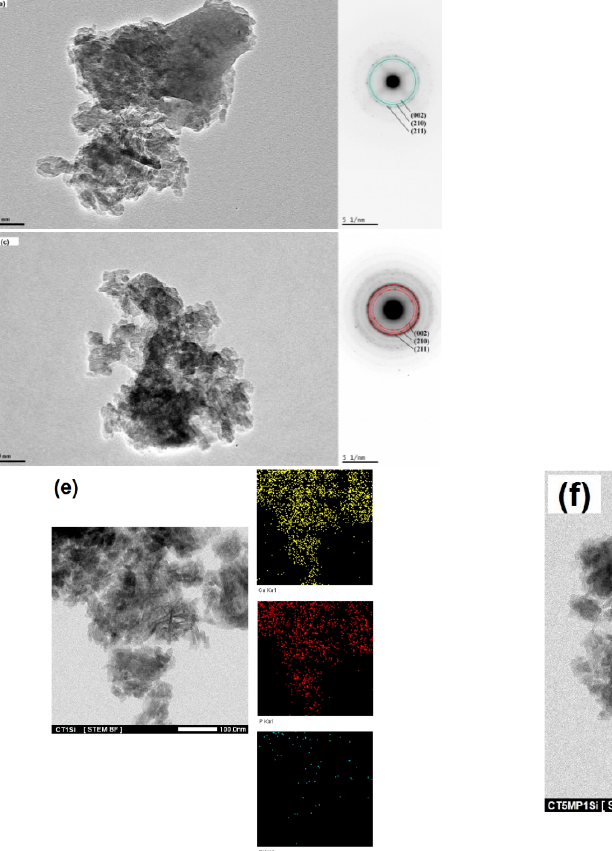
Figure 3. Microstructure of fractured cements after 7 days of hardening in SBF at 37 °C: CT ( a ),